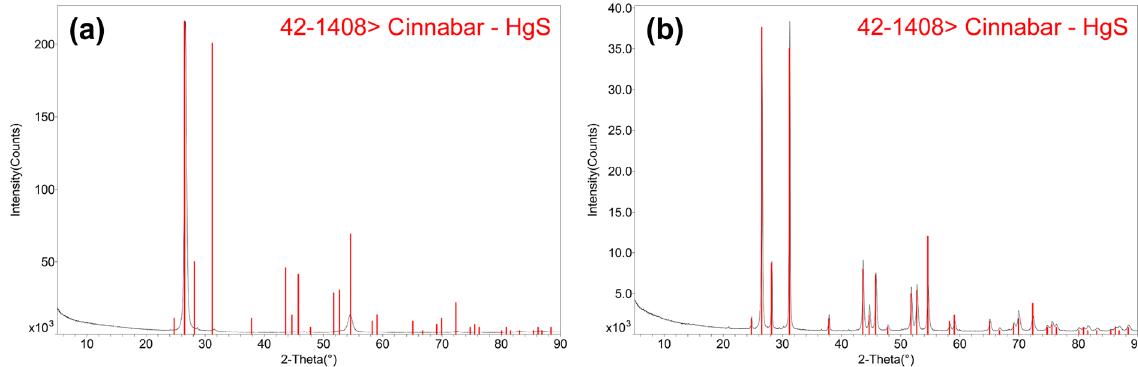
Fig. 9 Laboratory-type XRD patterns. a Polished gemstone. b Pigment powder